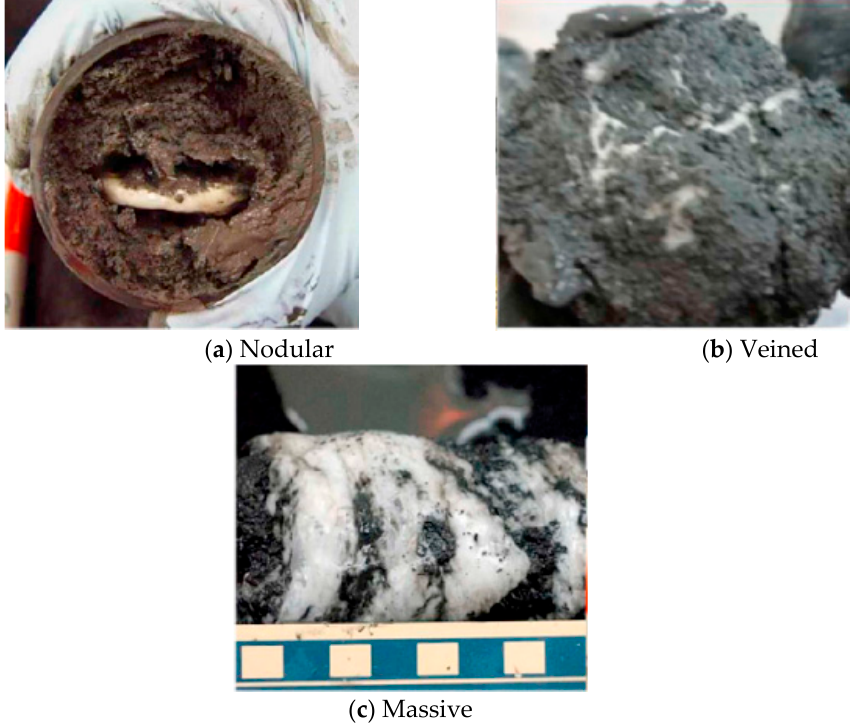
Figure 2. Hydrate occurrence modes in fine-grained sediments [22].